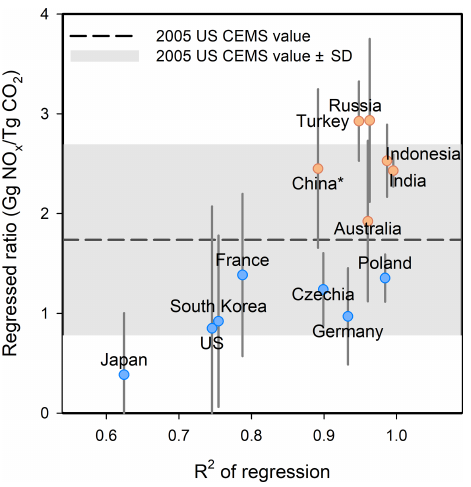
Figure 8. Comparison of the regressed NO x to CO 2 emission ra- tios derived from the global power emissions database (GPED) for different regions versus the correlation coefficient of the regression. The blue and red circles denote regions that are subject to more strict standards for NO x emissions from power plants (i.e., a NO x ELV of 200mgm − 3 or less) and other regions, respectively. The y axis is the slope of the regression of the NO x to CO 2 emissions with an as- sumed y -intercept of zero. Error bars show the standard deviations for the NO x to CO 2 emission ratios for individual power plants. The x axis is correlation coefficient of the regression. The dashed line represents 2005 US ratio CEMS for bituminous coal derived regressed ± in this study. The grey shadow represents 2005 US ratio CEMS regressed standard deviation. ∗ China switched from being a less strict country to a more strict country in 2014, when most coal-fired power plants in China were required to comply with its new emission standards